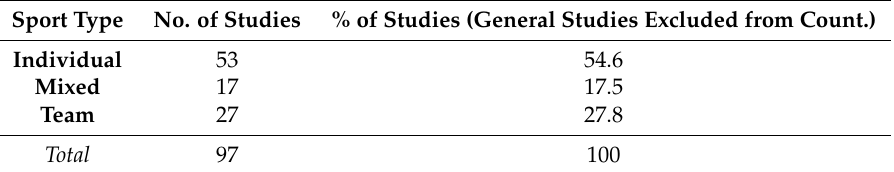
Table 4. Division of studies by sport